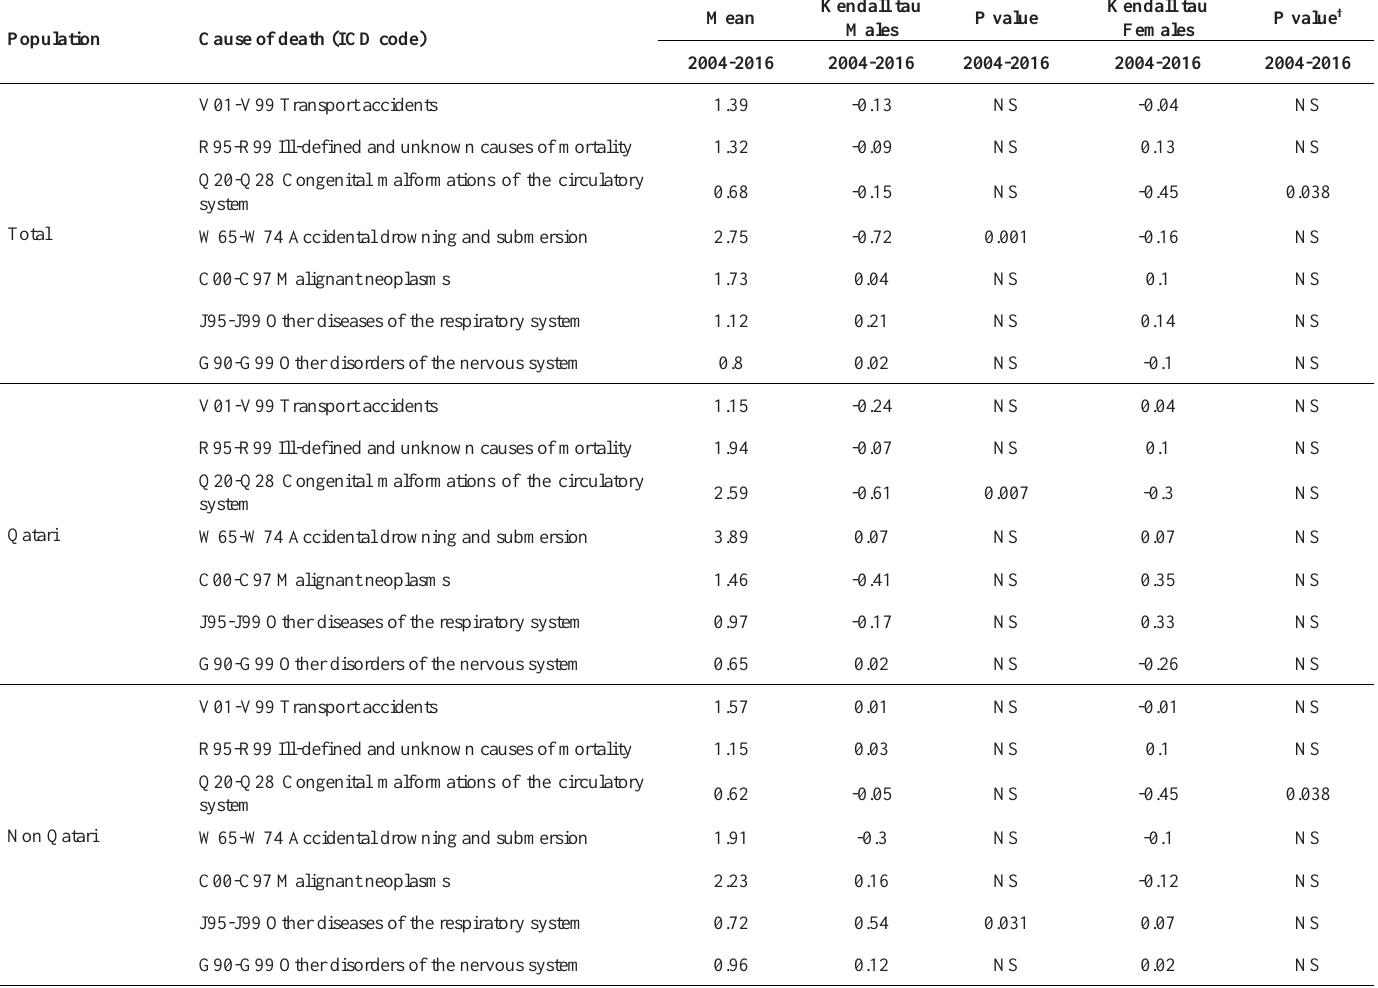
Table 4. The sex ratio (males to females) for total mortality and for the leading causes of child mortality in